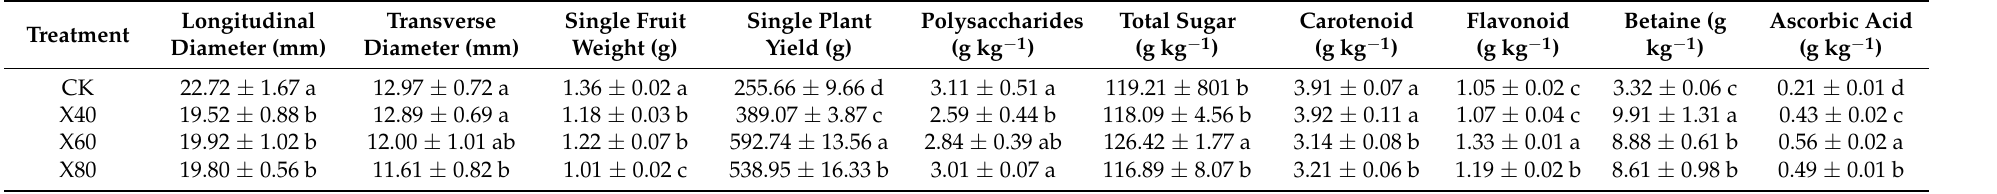
Table 2. Size and nutritional quality of L. barbarum fruit under different root-restriction treatments and no root-restriction cultivation.